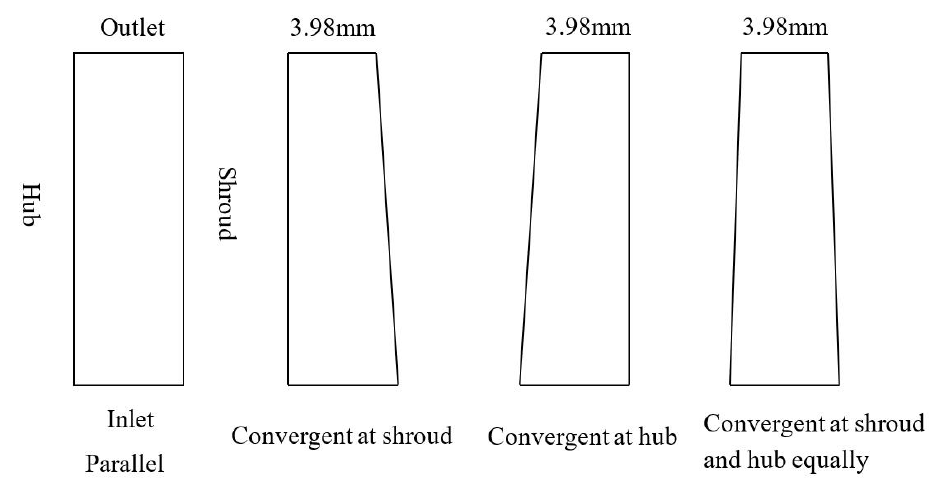
Figure 2. Vaneless diffuser axial geometry schematic. Table 1. Centrifugal compressor major geometry parameter.